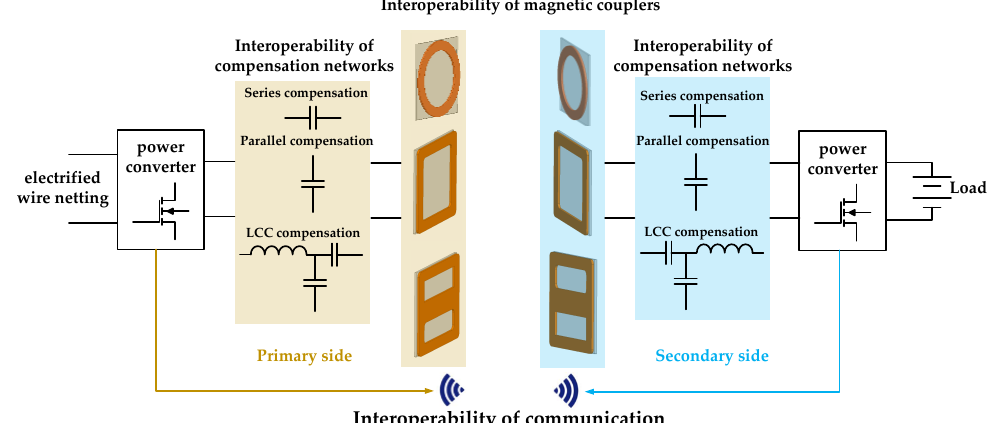
Figure 2. Three kinds of interoperability in wireless charging systems.